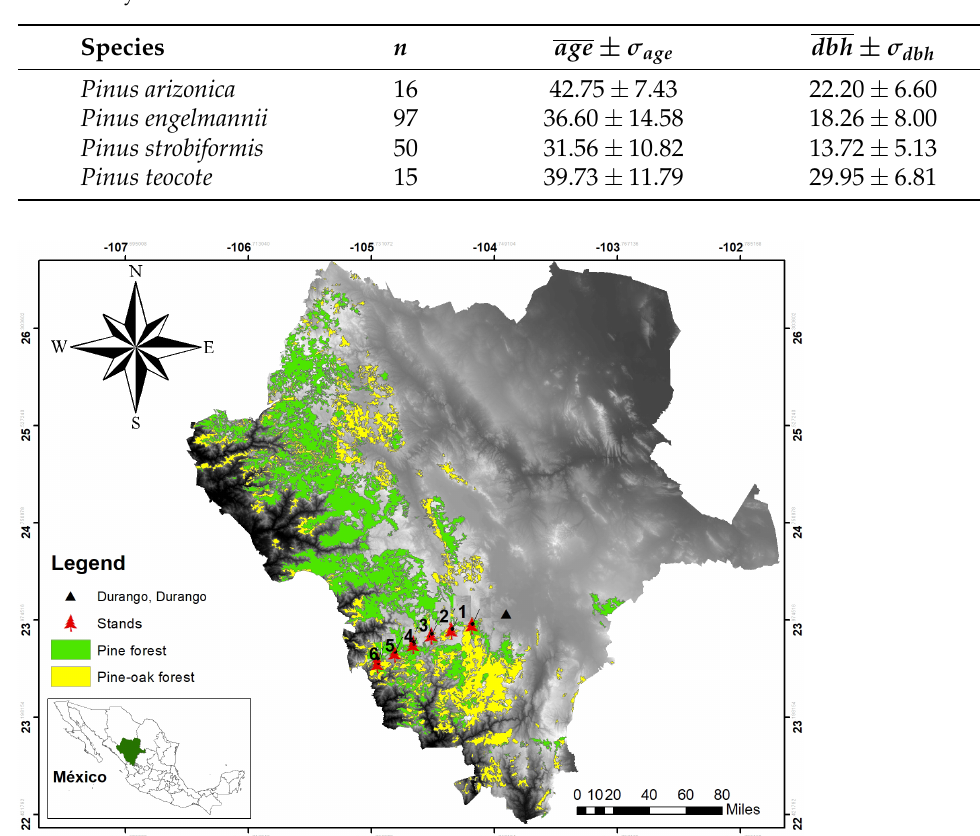
Table 1. Mean diameter at 1.30 m height ( dbh , cm) and respective standard deviation ( σ dbh ), mean age ( age , years) and respective standard deviation ( σ age ) and number of trees ( n ) of the four pine species in the study.